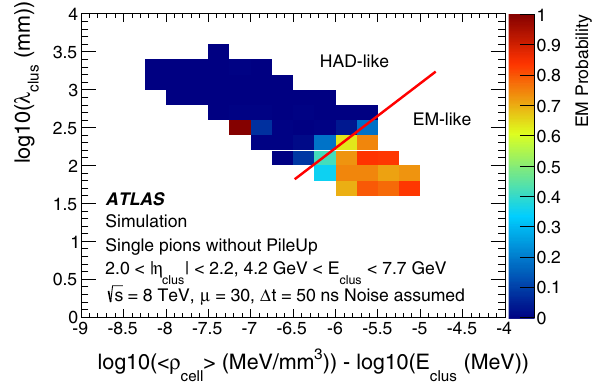
(ρ / E EM ,λ ) for Fig. 10 Distribution of the likelihood P EM clus clus clus clus reconstructedtopo-clusterstooriginatefromanelectromagneticshower as a function of the shower depth λ clus and the normalised cluster signal density ρ clus / E EM ,with ρ clus = (cid:7) ρ cell (cid:8) beingtheenergy-weightedaver- clus age of ρ cell . The shown distribution is determined as described in the text, in a selected bin of the cluster energy E EM and the cluster direction clus η P EM > 50% selection, clus . The red line indicates the boundary of the clus below which the topo-cluster is classified as mostly electromagnetic (“EM-like”)andabovewhichitisclassifiedasmostlyhadronic(“HAD- like”). The small EM-like area at the edge of the HAD-like region stems from neutral pions showering late. These areas are typical in regions of the detector where the second layer of the EM calorimeter is thinner and substantial parts of the shower are deposited in its last layer. The larger volume of the cells in this last layer leads to the reduced energy density while the position at the back of the EM calorimeter means a larger λ